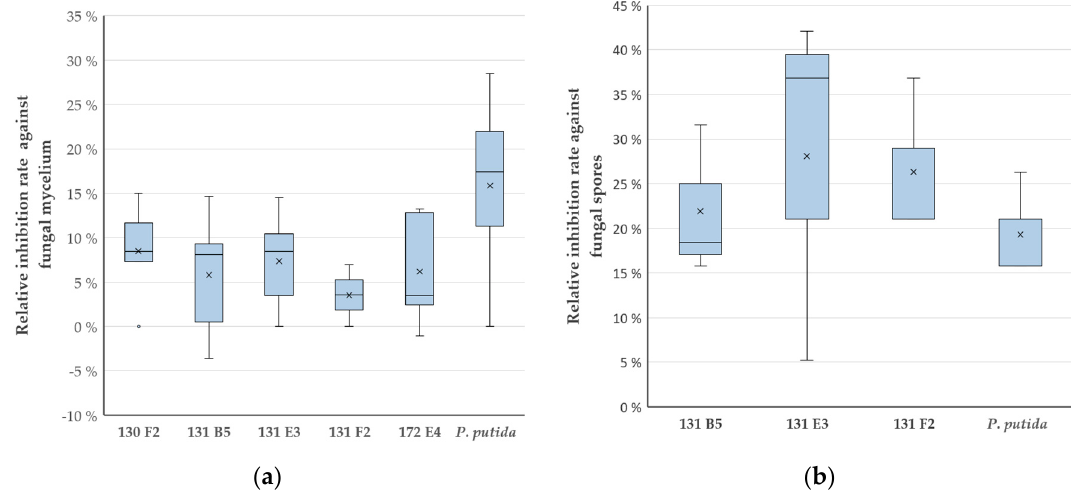
Figure 2. Effect of antagonistic fosmid clones from a moss metagenomic library on F. culmorum . Relative inhibition rates against fungal mycelium ( a ) and spores ( b ) of metagenomic clones and the reference strain Pseudomonas putida KTT2440 as compared to the empty vector control strain E. coli EPI300 pCC2FOS are displayed in percent. The box plots show the median (-), the mean (×), the outliers (°) and the standard deviation (whiskers) of samples; sample size n = 3.